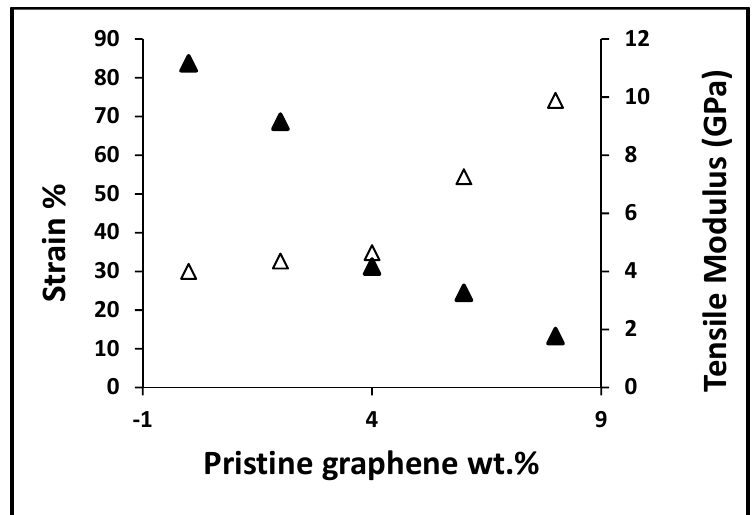
Figure 10. Tensile Modulus (GPa) ( ∆ ) and Strain variation ( ▲ ) in ArGr composites with different wt.% of Gr. Polymers 2020 , 12 , x